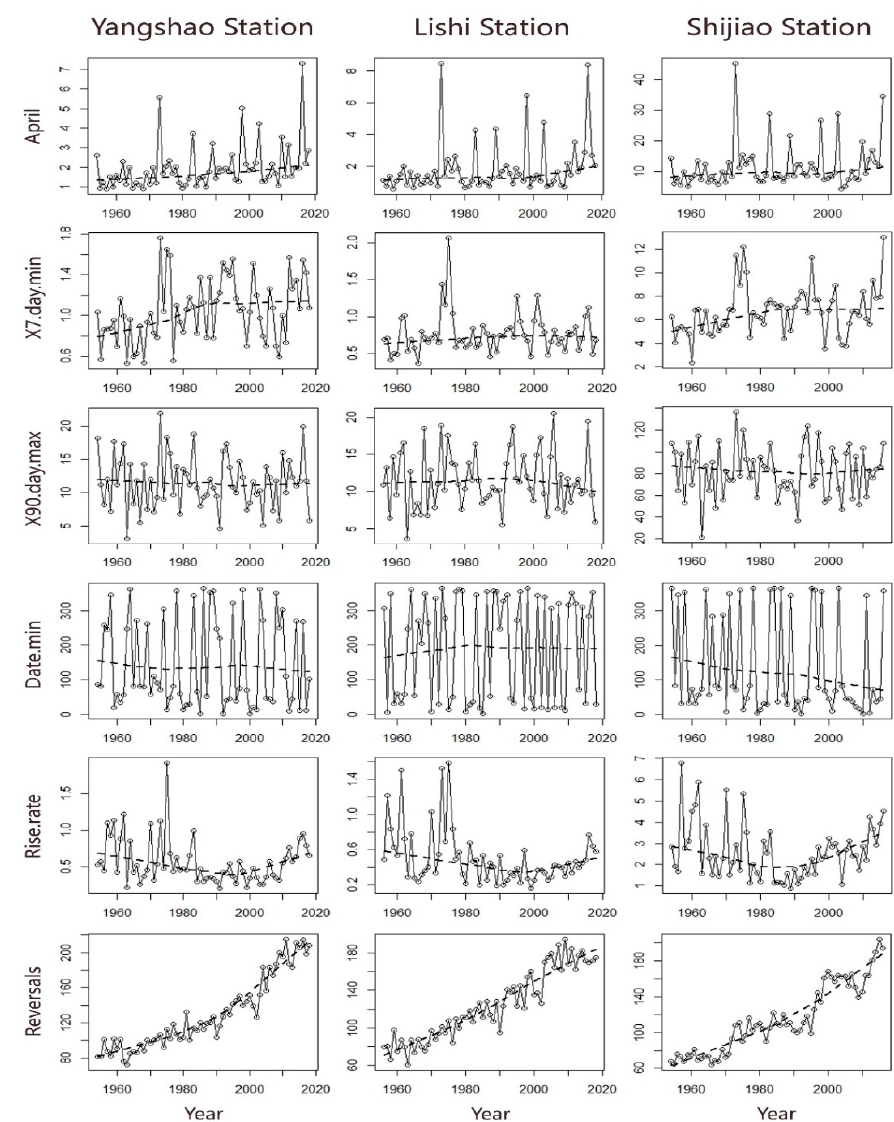
Figure 6. Yearly variations of ecologically relevant hydrologic indicators. X7.day.min denotes the minimum 7-day streamflow, X90.day.max denotes the maximum 90-day streamflow, and Date.min denotes the time when the minimum daily streamflow occurs (from April to March next year). Rise.rate denotes the rise rates, and Reversals denotes the number of hydrologic reversals. The dashed lines indicate the trend line of the construction time of the water reservoirs.